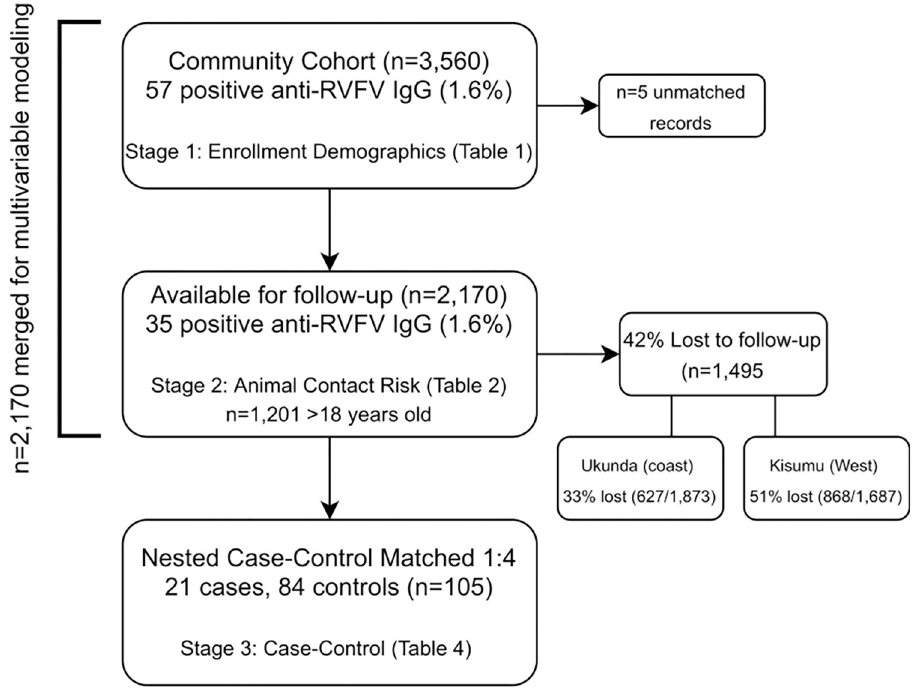
Fig 2. Study design indicating total number of participants assessed at each